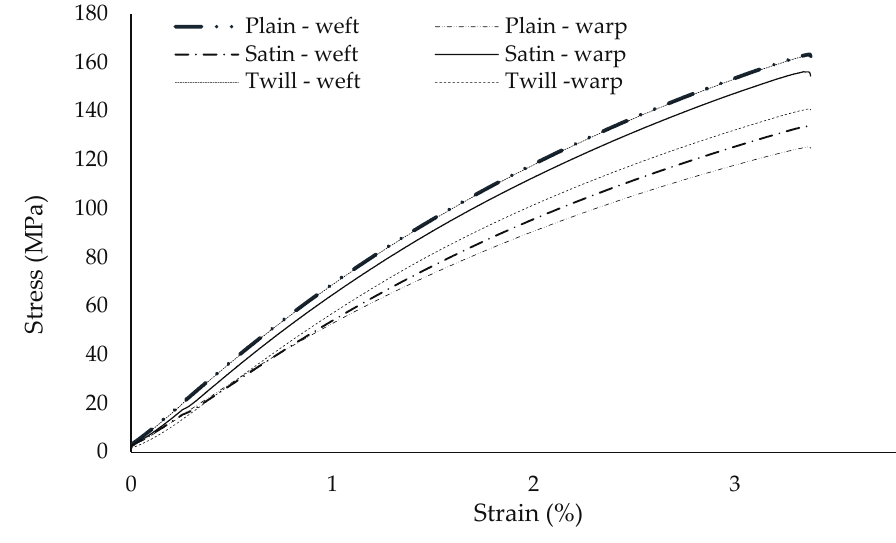
Figure 8. Stress-strain curve of flax composites.